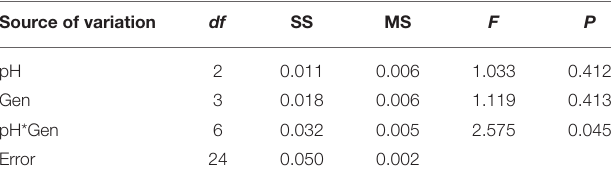
TABLE 4 | Short-term experiment